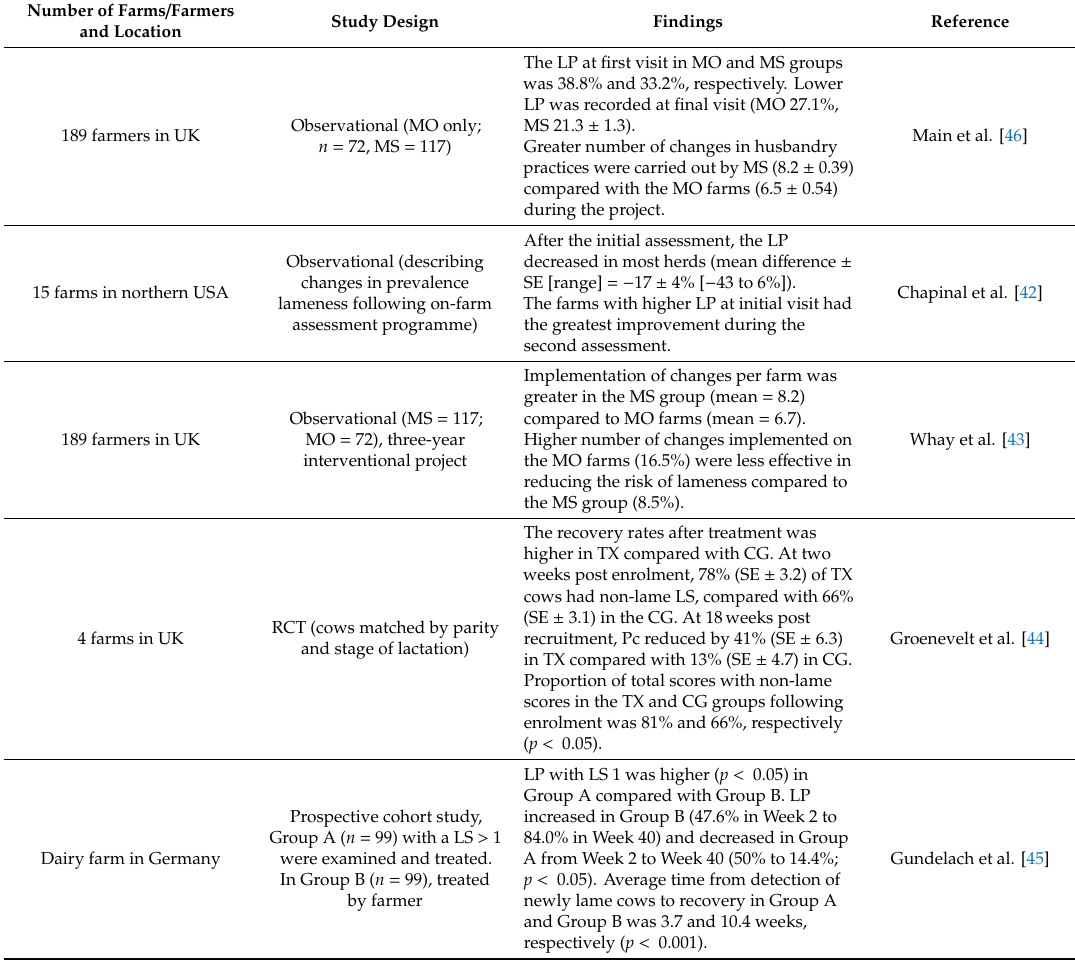
Table 2. Studies showing the role of trained personnel and farmers in the reduction of on-farm lameness